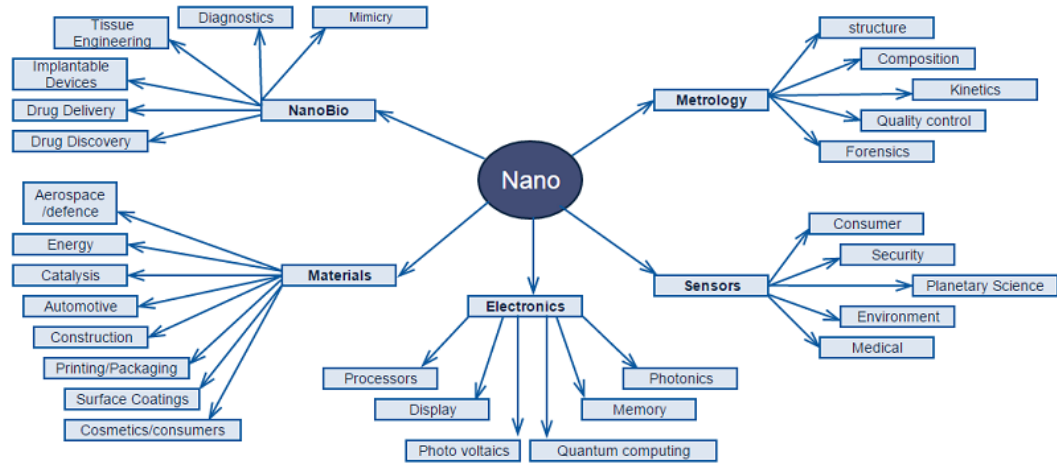
Figure 4. Applications in nanoscale.